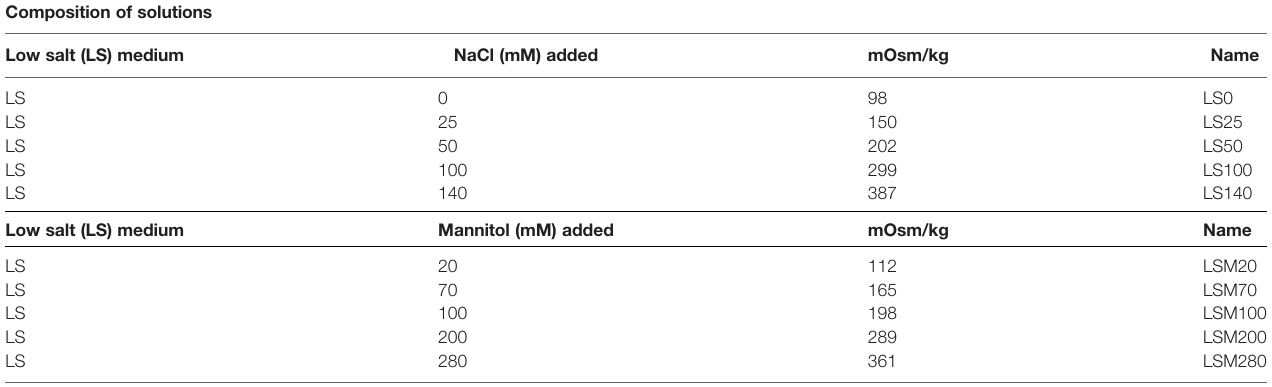
TABLE 1 | Compositions of cell culture medium containing different concentrations of NaCl and mannitol. Composition of